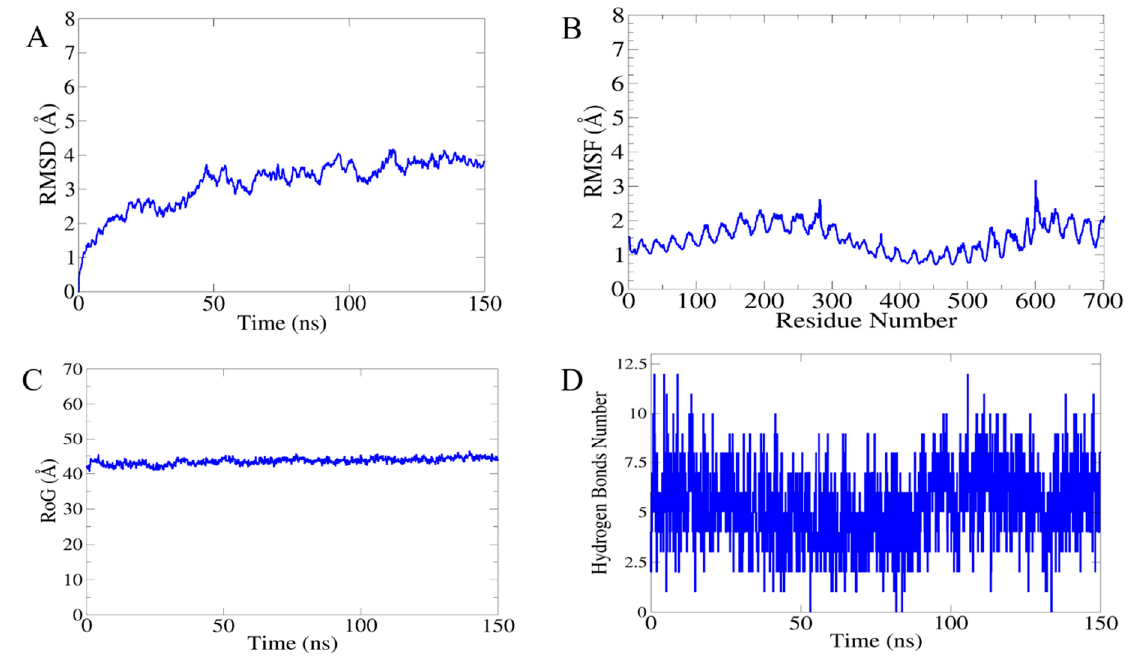
Figure 8. Statistical analysis of simulation trajectories: ( A ) root-mean-square deviation (RMSD), ( B ) radius of gyration (Rog), ( C ) root-mean-square fluctuation (RMSF), and ( D ) hydrogen bonding (H.B). Table 5. Binding free energies in